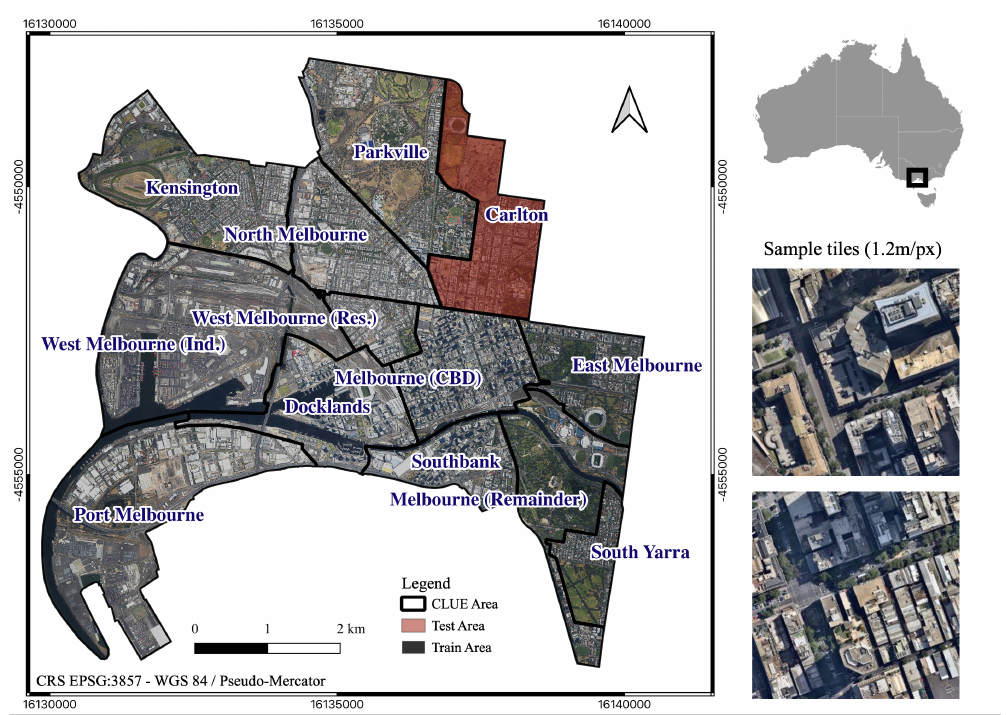
Figure 2. Study area of the City of Melbourne and sample training images of 1.2 m spatial resolution with high-rise building